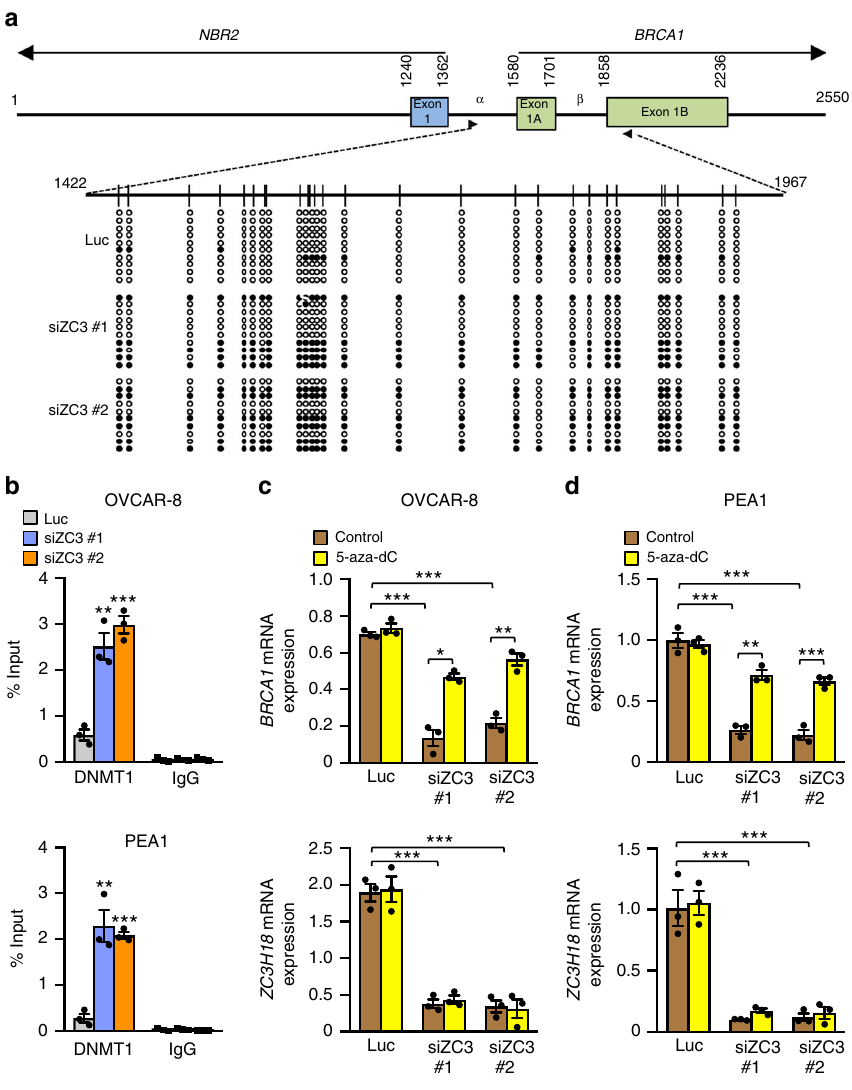
Fig. 3 ZC3H18 depletion causes hypermethylation of the BRCA1 promoter. a Map of the divergent BRCA1/NBR2 promoter with CpG islands indicated by circles below the map. Methylation patterns obtained by bisul fi te sequencing of 10 individual clones of PCR products from genomic DNA of control luciferase (Luc) and ZC3H18 siRNA (siZC3)-transfected OVACR-8 cells. Methylated ( fi lled circles) and unmethylated (open circles) CpG positions are shown. b ChIP assays showing increased DNMT1 occupancy on the BRCA1 promoter in ZC3H18-depleted cells. OVCAR-8 (top panel) and PEA1 (bottom panel) cells transfected with control luciferase (Luc) or ZC3H18 siRNAs were harvested 48 h after transfection and processed for ChIP to detect DNMT1 on the BRCA1 promoter. c and d OVCAR-8 ( c ) and PEA1 ( d ) cells were transfected with control (Luc) or ZC3H18 siRNAs and treated with vehicle or 5-aza-2 ′ - deoxycytidine (5 μ M) for 3 days. BRCA1 mRNA (top panel) and ZC3H18 mRNA (bottom panel) levels were analyzed by qRT-PCR. The mRNA levels are normalized to GAPDH mRNA levels as the internal control. Data are means ± SEM from three independent experiments in b – d . * p < 0.05, ** p < 0.01, *** p < 0.001, unpaired Student ’ s t-